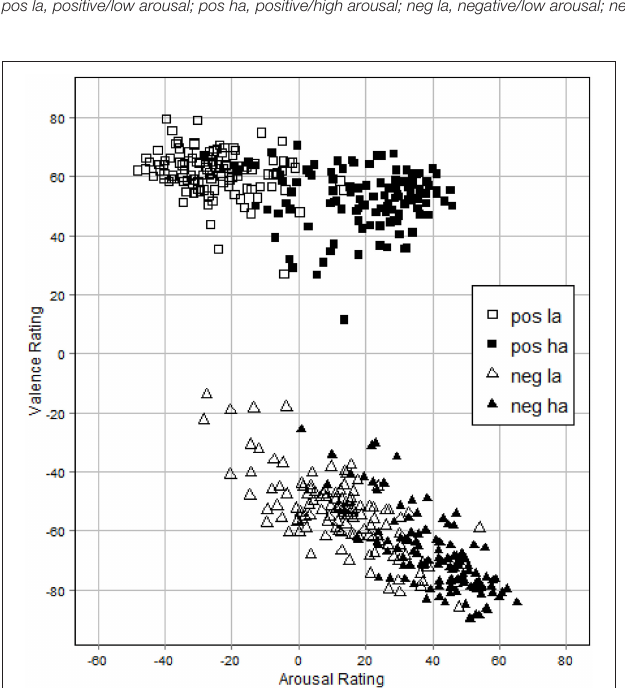
significant main effects formed an interaction on both valence and arousal ratings. In addition, all sets were tested for their internal consistency for both the 200 and the 1000 ms